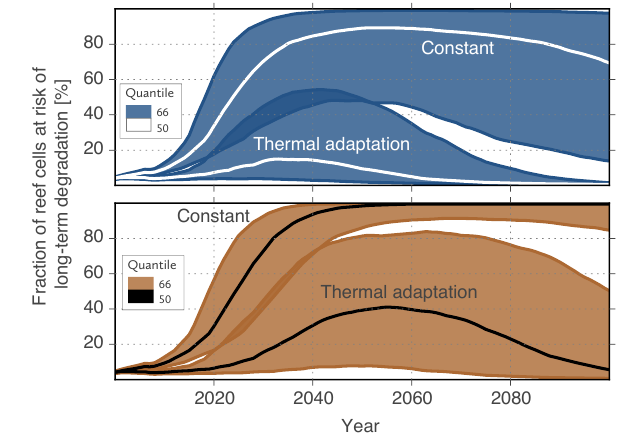
Figure 14. Probabilistic projections of the fraction of global tropi- cal coral reef cells suffering from long-term degradation under two illustrative 1.5 ◦ C (upper panel) and 2 ◦ C (lower panel) scenarios (see Fig. 13, upper panel) for two different assumptions about their adaptive capacity (see Sect. 7.1). Median projections and the 66% range are shown. Note that uncertainties also include uncertainties in the GMT response (see Fig. 13). See Sect. 7.1 for further de- tails on the methodology. Only the projections for the Constant and Adaptation scenario are shown, since the projections for the Sat- uration scenario differ only slightly from Constant . Table 3 gives results for all three scenarios assessed.